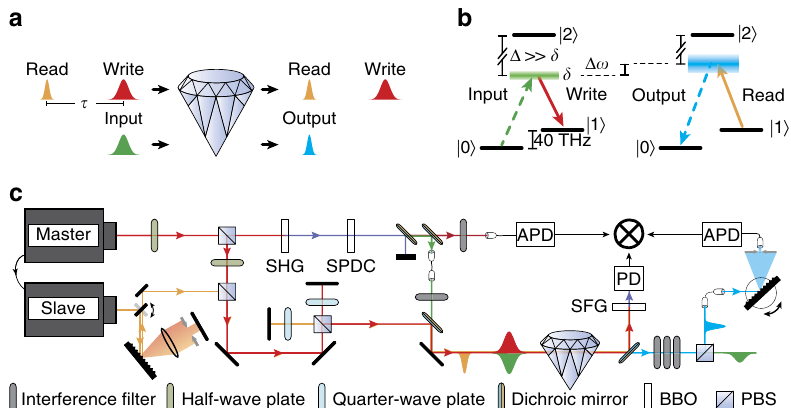
Figure 1 | Concept and experiment. ( a ) Input signal photons stored in the diamond by the strong write pulse can be retrieved with modified spectral properties upon output. The output spectrum is controlled by the spectrum of the read pulse. ( b ) Photons are Raman-absorbed to create optical phonons (|1 i ), 40THz above the ground state (|0 i ). A read pulse of tunable wavelength and bandwidth retrieves the photon, determining its spectrum. Here, D is the detuning from the conduction band (|2 i ), d is the input photon bandwidth, D o is the detuning between input and output frequencies. ( c ) The master laser (red) is split between the write field and photon source. In the photon source, frequency-doubled laser light pumps SPDC and heralded input signal photons (green) are generated. Signal photons are Raman-absorbed into the optical phonon modes in the diamond via the write field. The slave laser (orange) emits the read field which retrieves the photon from the diamond after time t . The output signal photon (blue) spectrum is measured on a monochromator. The SFG of read and write pulses triggers the experiment. Coincident detections of output, herald photons and SFG events are measured by a coincidence logic unit. SFG, second-harmonic generation; SPDC, spontaneous parametric downconversion; APD, avalanche photodiode; PD, photodiode; SFG, sum-frequency generation; BBO, b -barium borate; PBS, polarizing